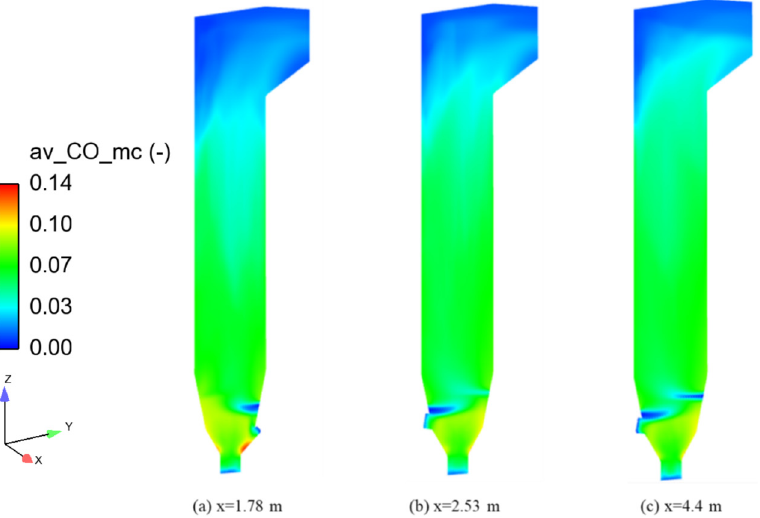
Figure 10. Contours of CO concentration at key vertical sections of the biomass CFB boiler in Case 1 (( a ) − returning port; ( b ) − secondary air port; ( c ) − fuel-feeding port).